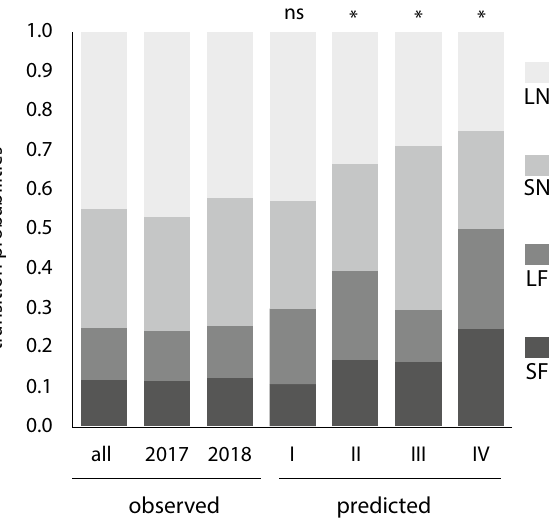
Figure 3. Observed and predicted transition probabilities for each patch type, for both years combined (all), for 2017, and for 2018. Using this figure, one can compare the transition probabilities observed for each patch type, large near (LN), small near (SN), large far (LF), and small far (SF), for a given year (2017 or 2018) or combination of years, to the transition probabilities predicted per patch type by each of the four models of patch attractiveness (I, II, III and IV). We obtained the same pattern for 2017, 2018 and both years combined, with Model I best predicting the observed probabilities of transitioning to the different patch types. A non-significant (ns) model indicates a good fit to the data. A * refers to a model with a probability P < 0.05. Model I indicates that bees use information on both distance and total resources available, when selecting a patch.